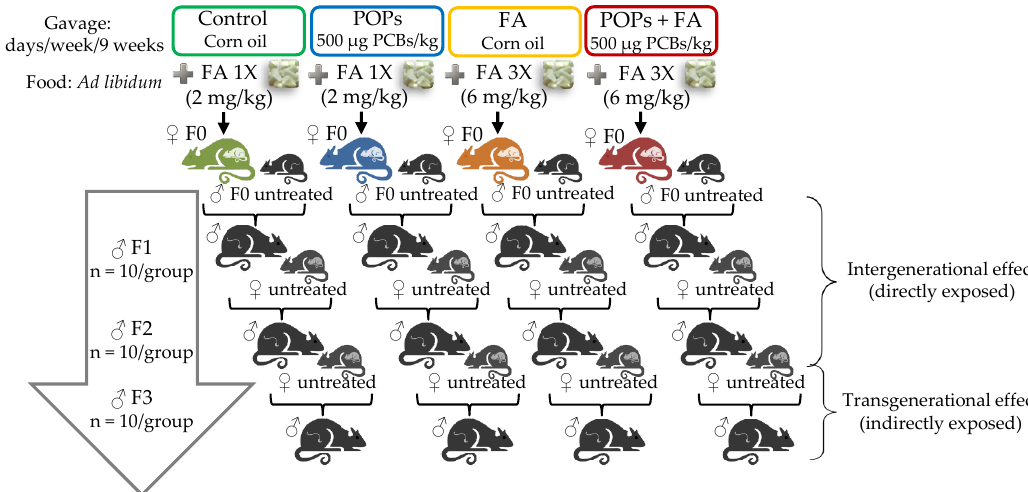
Figure 1. Experimental design. Four treatment groups of Sprague–Dawley F0 founder dams were fed ad libitum with a diet containing 2 (1×) (CTRL) or 6 mg/kg diet (3×) of FA and received by gavage (3 days/week) either corn oil (CTRL) or the POP mixture. Treatments started before reproduction with untreated males and were administered until parturition (9 weeks in total). All F0 postpartum founder dams and subsequent generations were fed the control diet 1× ad libitum only and the POP mixture treatment was ended. Then, F1 males were mated with untreated females to yield generation F2 and so on until F3 lineage. Since F1 males were exposed to treatments in utero and F2 were exposed as germ cells in utero, F1 and F2 phenotypic variations were defined as “intergenerational”. F3 generation was not directly exposed (ancestral exposure), so F3 phenotypic variations were defined as “transgenerational”.